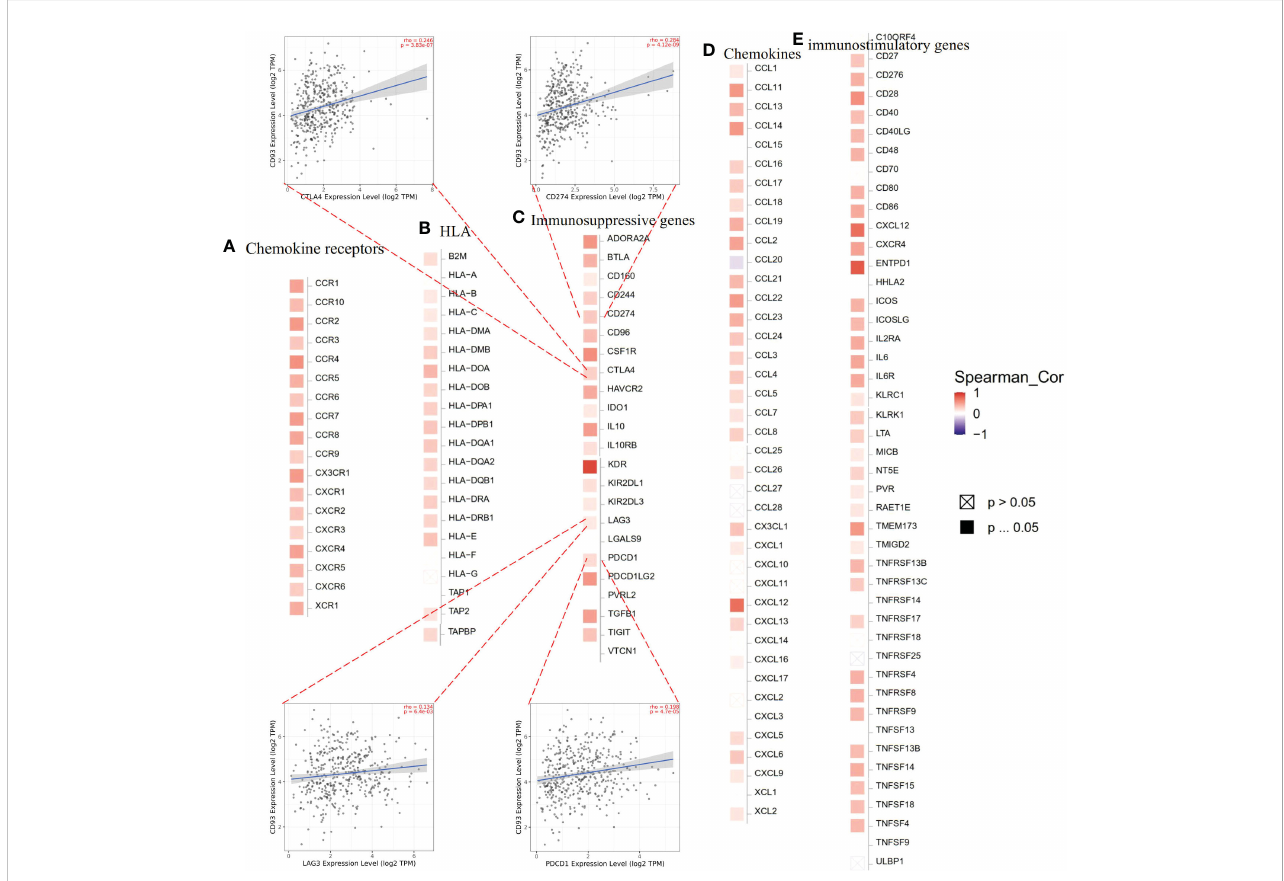
FIGURE 4 Expression correlations between CD93 and immune-related genes according to TIMER2.0 database: (A) chemokine receptor genes, (B) HLA, (C) immunosuppressive genes, (D) chemokine genes, and (E) immunostimulatory genes in stomach